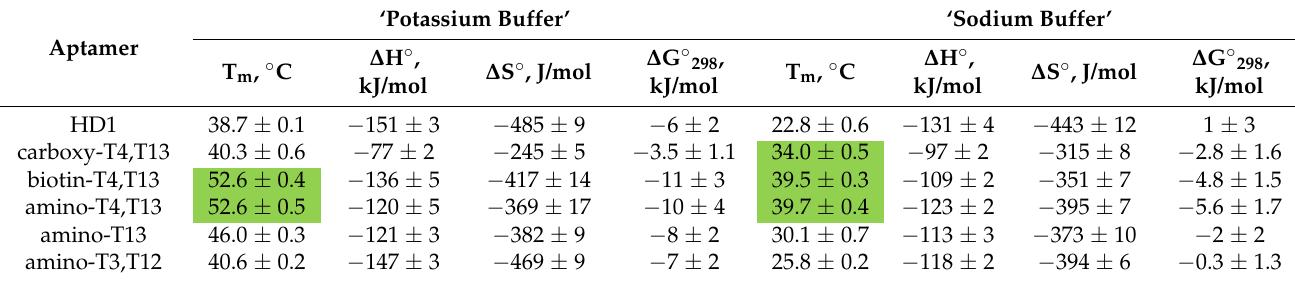
Table 4. The structural characteristics of the aptamers in two buffer systems. The data derived from circular dichroism experiments: melting temperatures (T m ), enthalpy changes ( ∆ H ◦ ), entropy changes ( ∆ S ◦ ), and Gibbs free energy changes ( ∆ G ◦ 298 ) during G-quadruplex folding. The data for the aptamers with melting temperature increases of 10 ◦ C and more are highlighted in